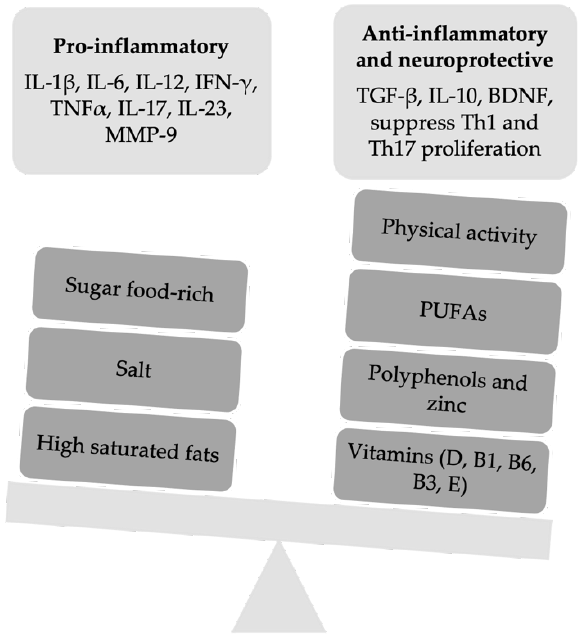
Figure 1. A summary of the slight imbalance between pro-inflammatory and anti-inflammatory factors of the innate and adaptive immune response. IFN, interferon; Th, T helper cells; MMP-9, metalloproteinasis-9; TGF, transforming growth factor; BDN, brain-derived growth factor; PUFAs, omega-3 polyunsaturated fatty acids.